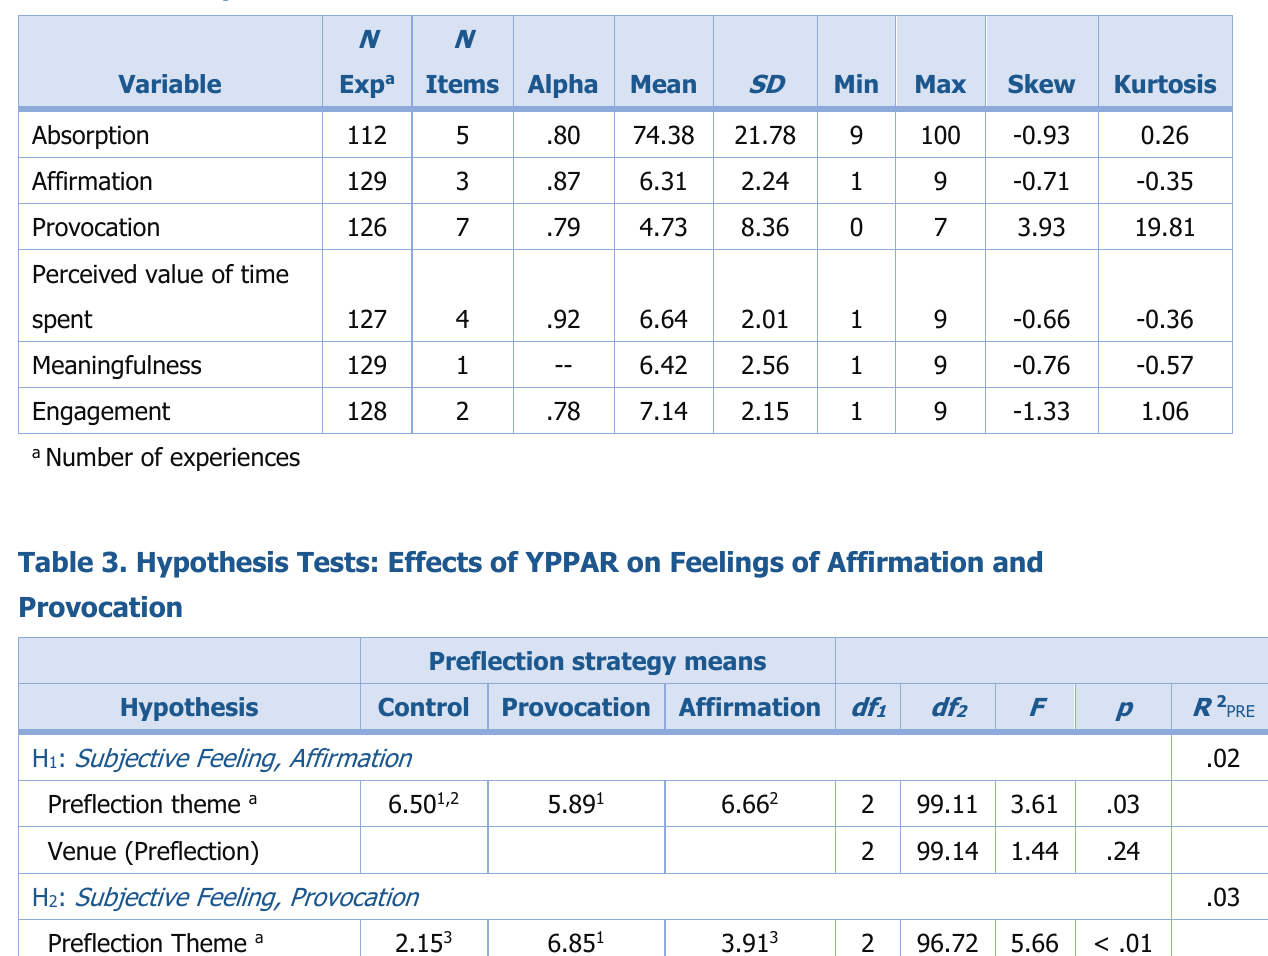
Table 2. Descriptive Statistics